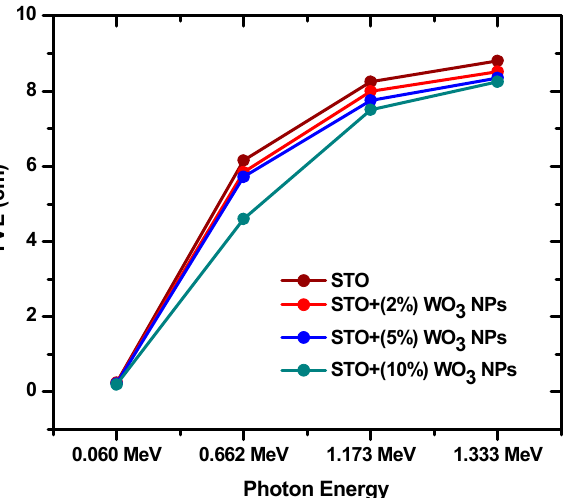
Figure 6. Tenth value layer of STO ceramic and STO ceramic doped with x% of WO 3 NPs. The mean free path (MFP) of the STO ceramics is shown in Figure 7 at the four tested energies. The maximum MFP values occur for the STO ceramic, while the ceramic with 10% WO 3 nanoparticles has the minimum MFP values. For example, at 0.060 MeV, the STO ceramic has an MFP value of 0.107 cm, while the ceramic with 10% WO 3 NP has an MFP value of 0.086 cm. Thus, the amount of WO 3 in the ceramic mixture correlates with more collisions occurring within the sample, leading to greater attenuation. Furthermore, for any single ceramic, its MFP values increase with energy. For instance, STO-5WO 3 ’s is equal to 0.099 cm, 2.486 cm, 3.367 cm, and 3.628 cm at 0.060, 0.662, 1.173, and 1.333 MeV. Higher energy radiation tends to pass through the samples more easily, decreasing the number of collisions and increasing the distance between collisions. Thus, ceramics are able to attenuate lower energy photons than higher energy ones. The results of LAC, HVL, and MFP, as well as the mass attenuation coefficient (MAC), are reported in Table 2. Table 2. The experimental values of the attenuator parameters for STO-ceramic samples. Code